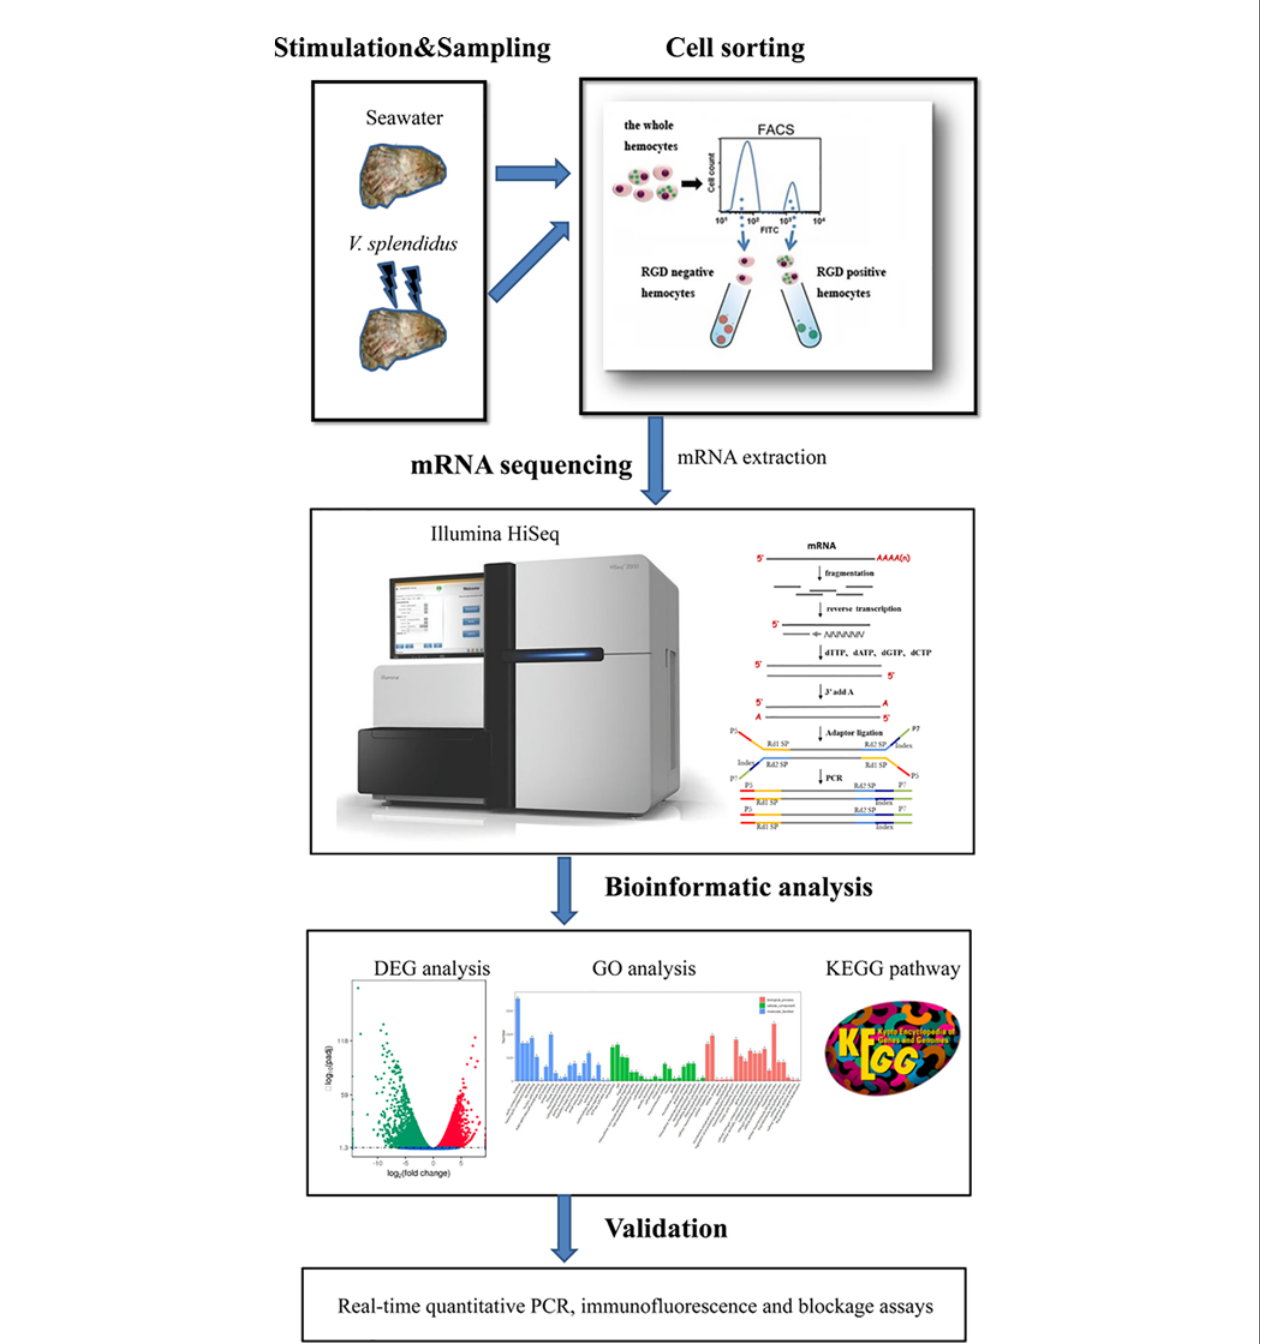
FIGURE 1 | Pipeline overview of analyses of the molecular mechanisms for the mediation of high migration activity and regulation of antimicrobial immunity of C. gigas RGD + hemocytes. The hemocytes were collected, incubated with FITC-conjugated RGDCP, and sorted using FACS to prepare both RGD + hemocytes and RGD - hemocytes. The differential expression in RGD + hemocytes before or after V. spelendidus infection was revealed by transcriptome bioinformatic analyses, including DEG, GO term, and KEGG pathway analyses. The molecular mechanisms for the mediation of high migration activity and regulation of antimicrobial immunity were revealed based on DEGs and further validated using qPCR, receptor blocking assay, and confocal